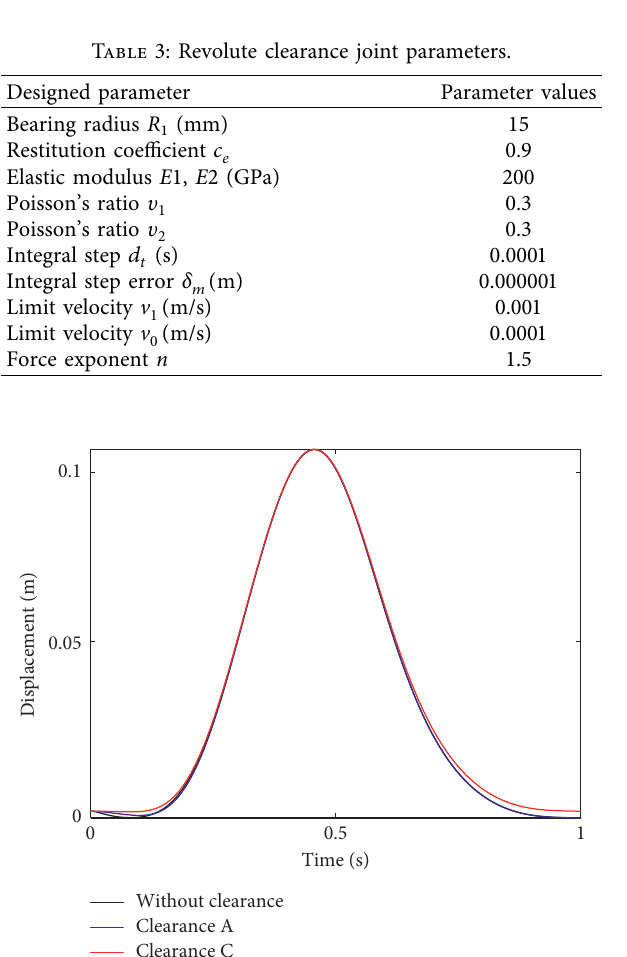
Figure 4: Displacement of the slider under different clearance positions.